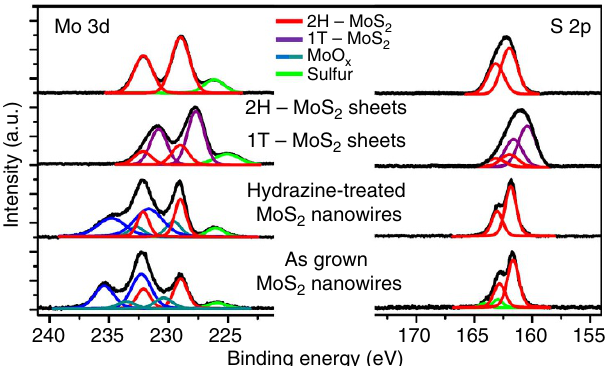
Figure 3 | XPS Spectroscopy following hydrazine treatment. Spectra for MoO x /MoS 2 core-shell nanowire array before and after hydrazine treatment, showing the Mo 3d, S 2s, and S 2p core level binding energies. The red curves denote the Mo 3d and S 2p signals corresponding to 2H- MoS 2 , with the purple curves showing the shift resulting from the phase transformation to 1T-MoS 2 . The MoO x core seems to be a mixed phase valence, the Mo 3d oxidation states are shown by the dark and light blue curve, and sulfur signals are denoted by